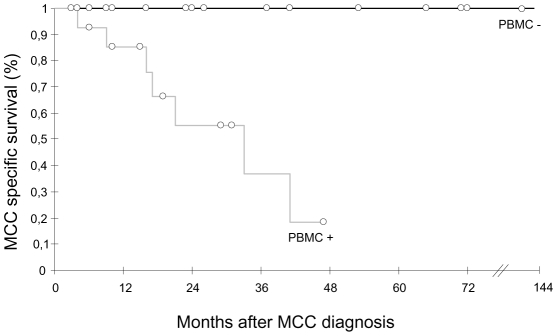
Kaplan Meier analysis of overall survival relative to MCPyV detection in PBMC.Patients who had all MCPyV-negative PBMC (n = 14, black curve) had a longer survival than patients who had at least one MCPyV-positive PBMC (n = 14, grey curve). Open circles indicate patients censored at last follow-up visit.